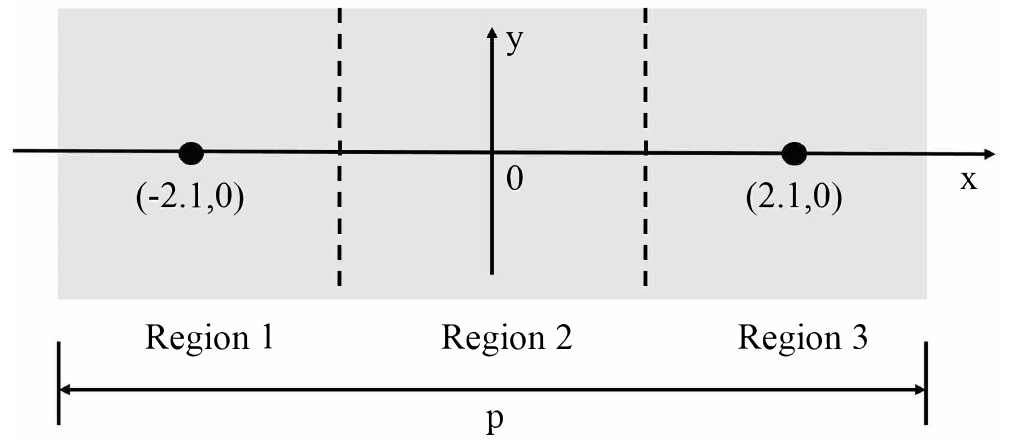
Figure 3. The volunteer’s thumb is placed at different regions on the surface of the prism: region 1–3. Free area for sample placement is 2.5 cm (width) × 6.2 cm